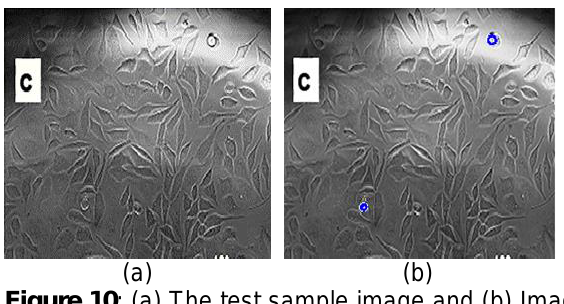
Figure 10 : (a) The test sample image and (b) Image illustrates the highlighted